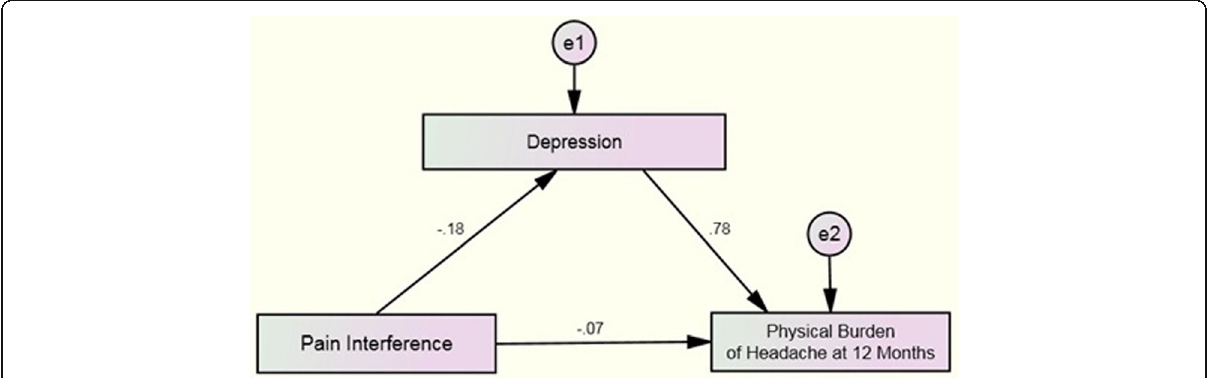
Fig. 1 Mediation Analysis of Pain Interference on Physical Burden of Headache at one-year through